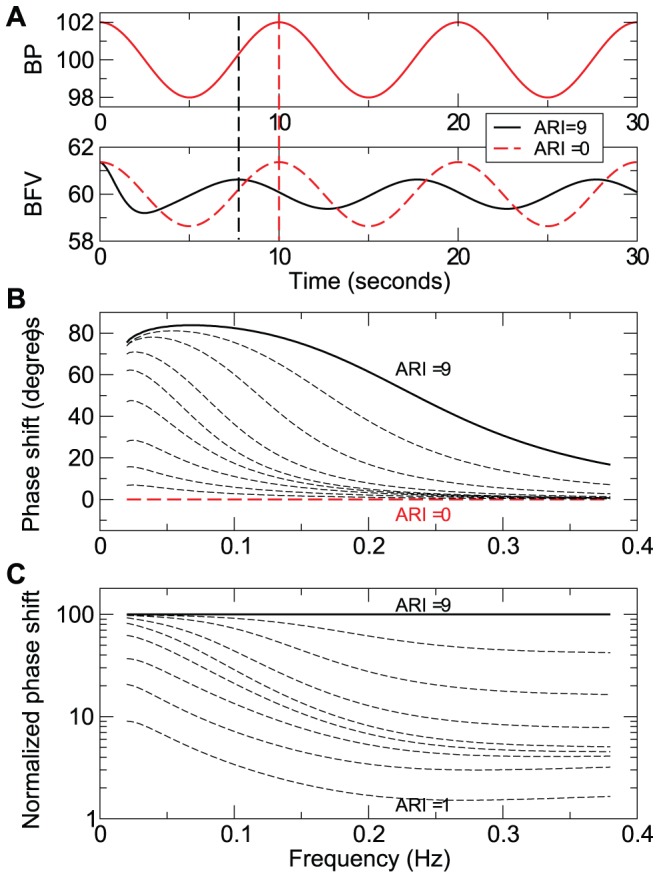
Frequency-dependent phase shift between BP and BFV oscillations in the Aaslid-Tiecks model.(A) BP oscillations at certain frequency induced oscillations in BFV at the same frequency. In the Aaslid-Tiecks model [56], cerebral autoregulation is estimated by a dynamic autoregulation index (ARI) that ranges from 0 (absence of cerebral autoregulation) to 9 (best autoregulation). When cerebral autoregulation is absent (ARI = 0), there is no phase shift between BP and BFV oscillations, i.e., the locations of BFV and BP peaks coincide. (B) BFV-BP phase shift at different frequencies for different autoregulation (ARI = 0 to 9 from bottom to top). (C) Normalized BFV-BP phase shift as percentages of values of ARI = 9. Curves from bottom to top correspond to ARI = 1 to 9, respectively. Note that y axis was in log scale. Results in B and C showed that BFV-BP phase shift decreased with increasing frequency and that phase shift is larger for larger ARI at all tested frequencies (0.02–0.38 Hz).